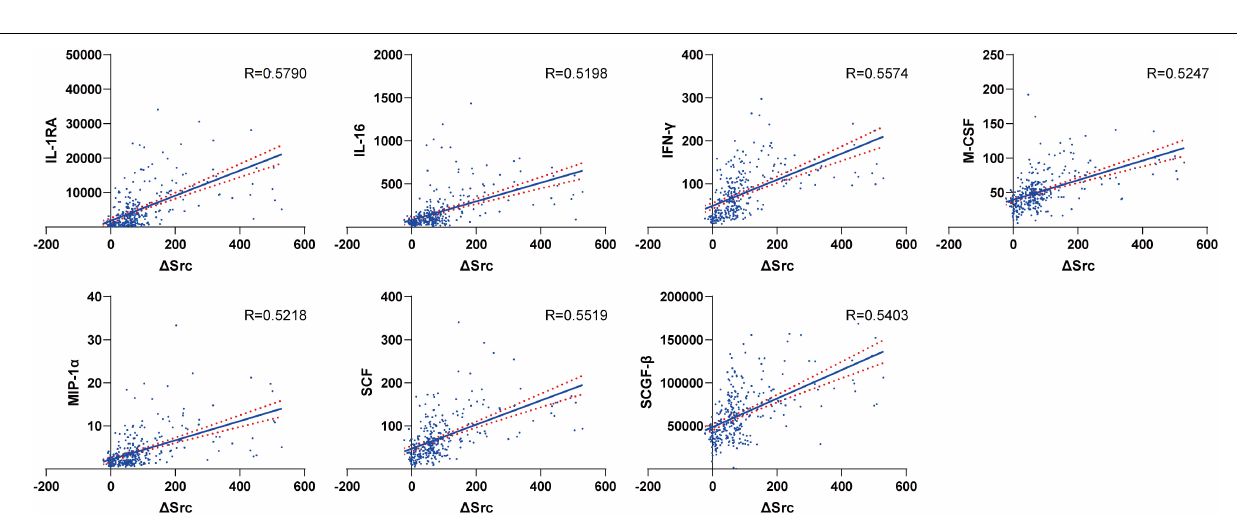
probability of factors combination, which was used to draw the ROC (receiver-operating characteristic curve) curve consequently to display the performance. Pearson correlation